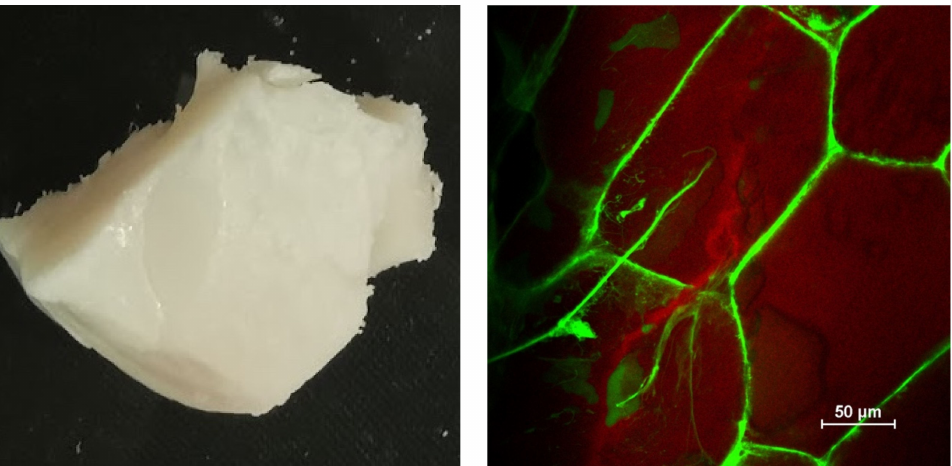
Figure 2. Appearance and microstructure of beef adipose tissue determined by digital photography and confocal fluorescence microscopy.